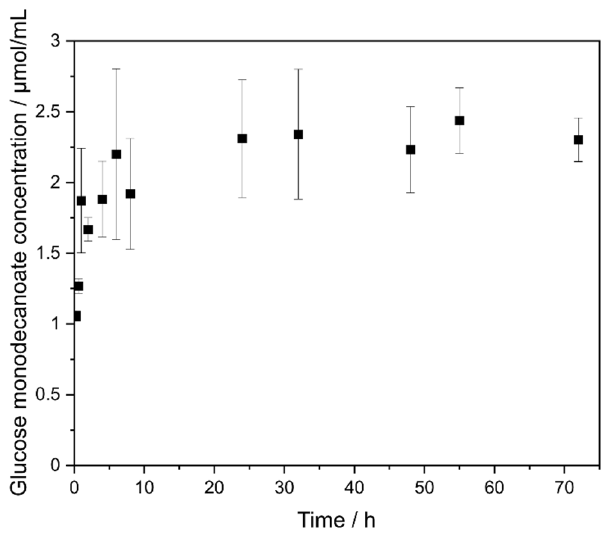
Figure 1. Glucose monodecanoate concentration in relation to operation time of the packed bed reactor.